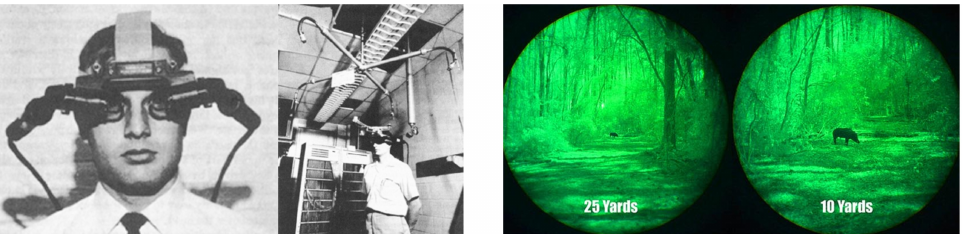
Figure 1. The head-mount displays (HMD) introduced by Ivan Sutherland’s research team were the first HMD prototype ( left ). The night vision device introduced by the US Army during the Vietnam War allows the viewing of targets in low light and range estimation ( right ).